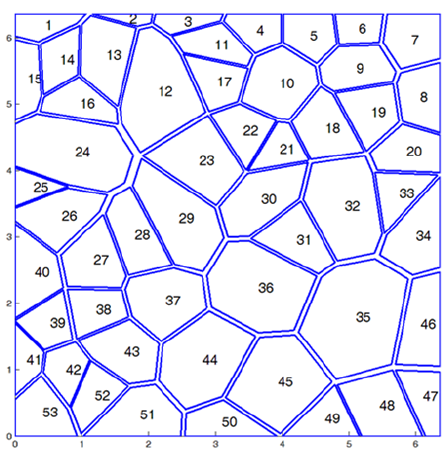
Figure 5: Material microstructure of polycrystalline Copper numerically analyzed in this work.